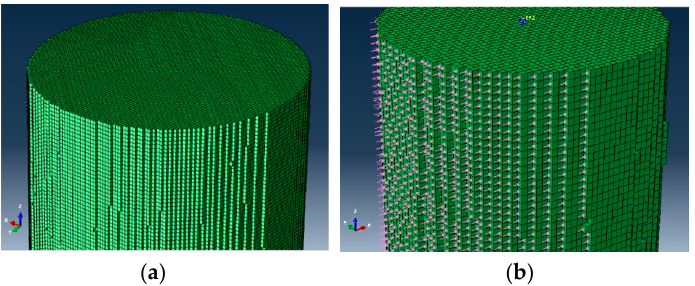
Figure 8. ( a ) Element side surface of the asphalt mixture numerical model; ( b ) S6 type element surface searching results.